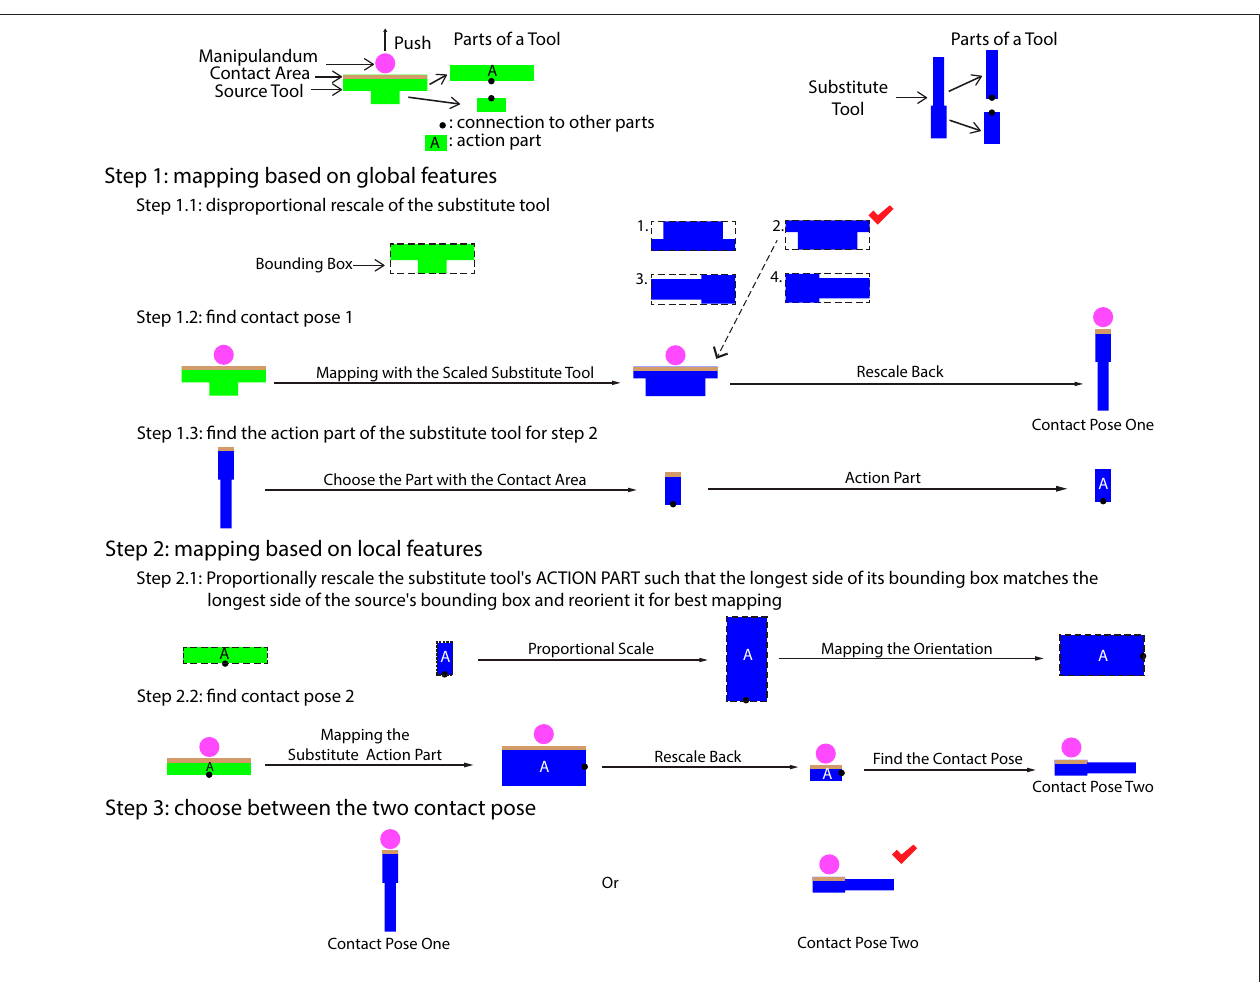
FIGURE 3 | Mapping procedure for a hypothetical 2D tool substitution